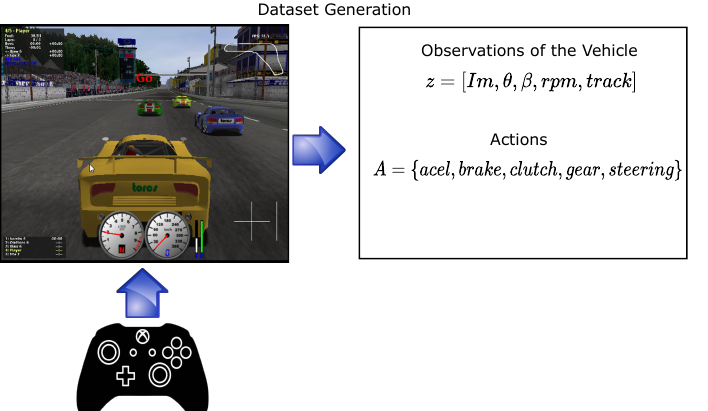
Figure 3. Using TORCS simulator with ROS compatibility to obtain the data from a human